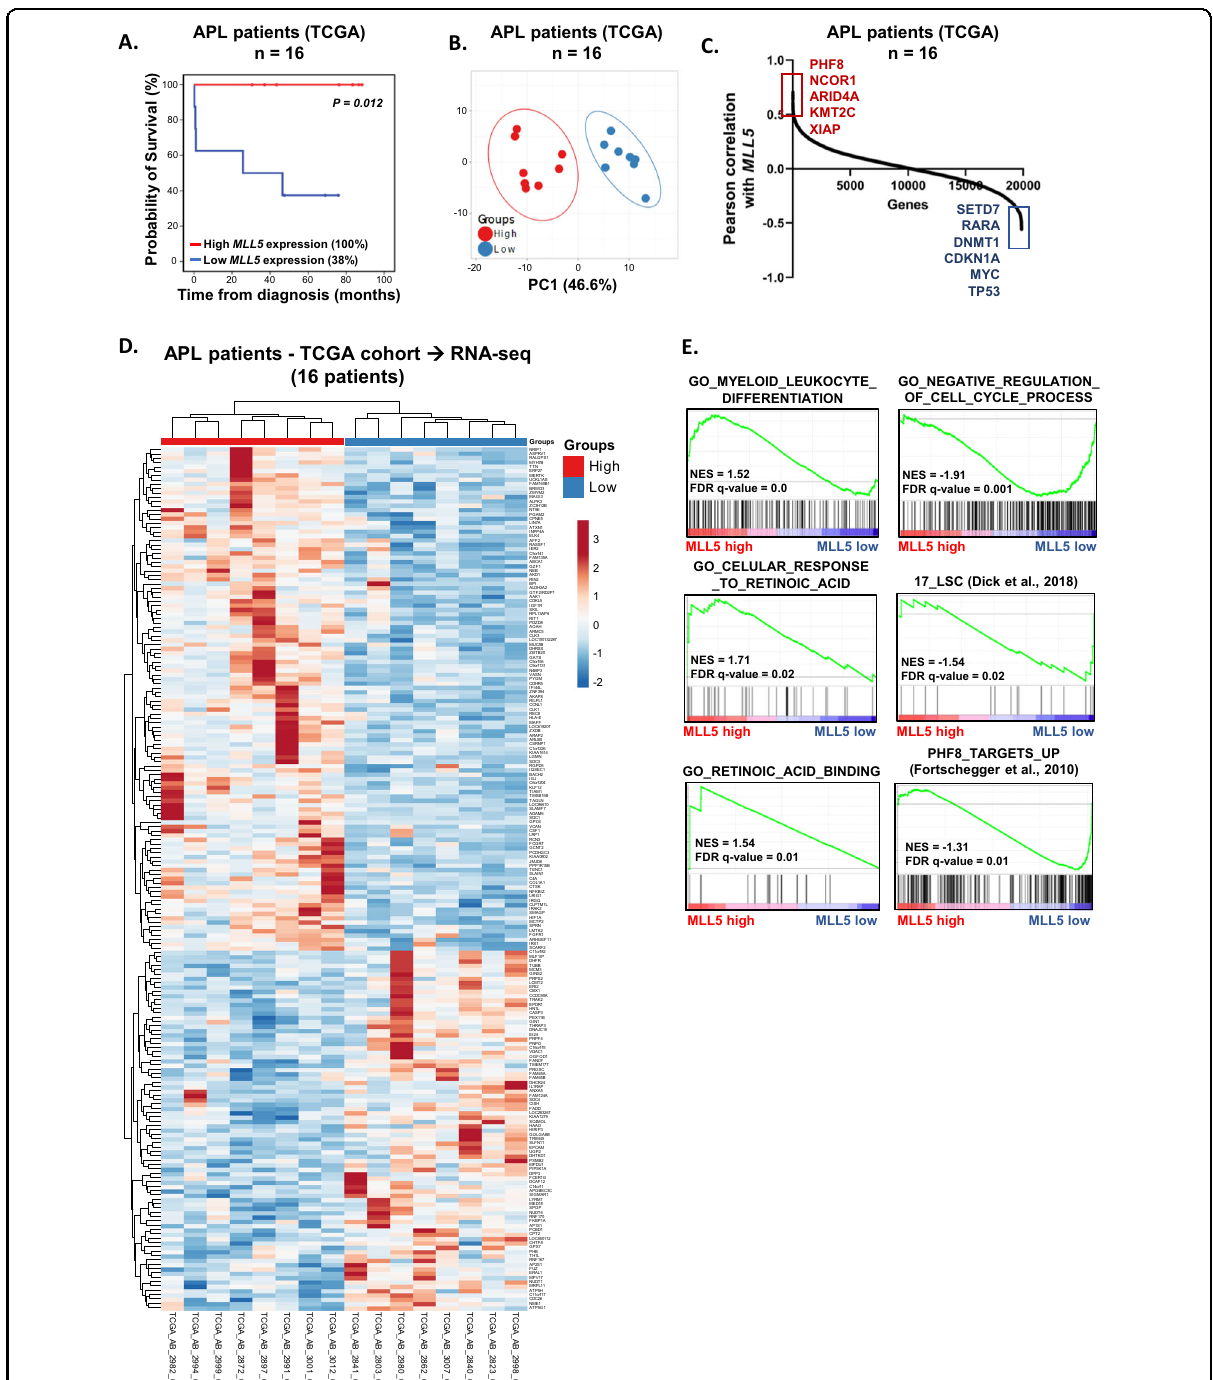
Fig. 1 Differential expression of MLL5 de fi nes different biology in APL patients. The probability of overall survival in patients with APL included in the TCGA study according to MLL5 gene expression ( A ). Survival curves were estimated using Kaplan – Meier method, and the log-rank test was used for comparison. B Principal component analysis showing the differences in gene expression for APL patients included in the TCGA cohort dichotomized by MLL5 expression (high and low expression). Pearson correlation shows the positively and negatively correlated genes with MLL5 gene in APL patients (TCGA cohort). C Heatmap of differentially expressed genes (supervised clustering) in APL samples from TCGA cohort dichotomized according MLL5 gene expression (dichotomization point: median value; groups: high and low expression; n = 8 in each group). D Gene set enrichment analysis (GSEA, lower panels) on a ranked gene list based on the leading-edge genes for MLL5 expression in 16 de novo APL patient samples from TCGA study. Genes were ranked based on Pearson correlation with MLL5 gene expression. Normalized enrichment score (NES) and false discovery rate (FDR) was used for signi fi